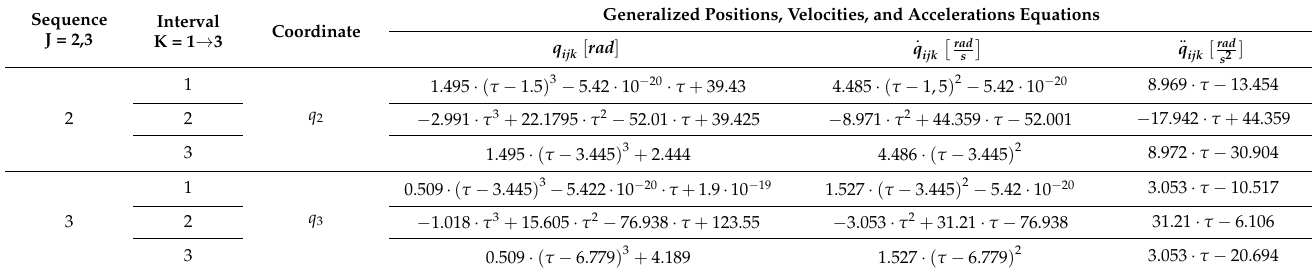
Table 3. The positions, velocities, and acceleration expressions for joints 2 and